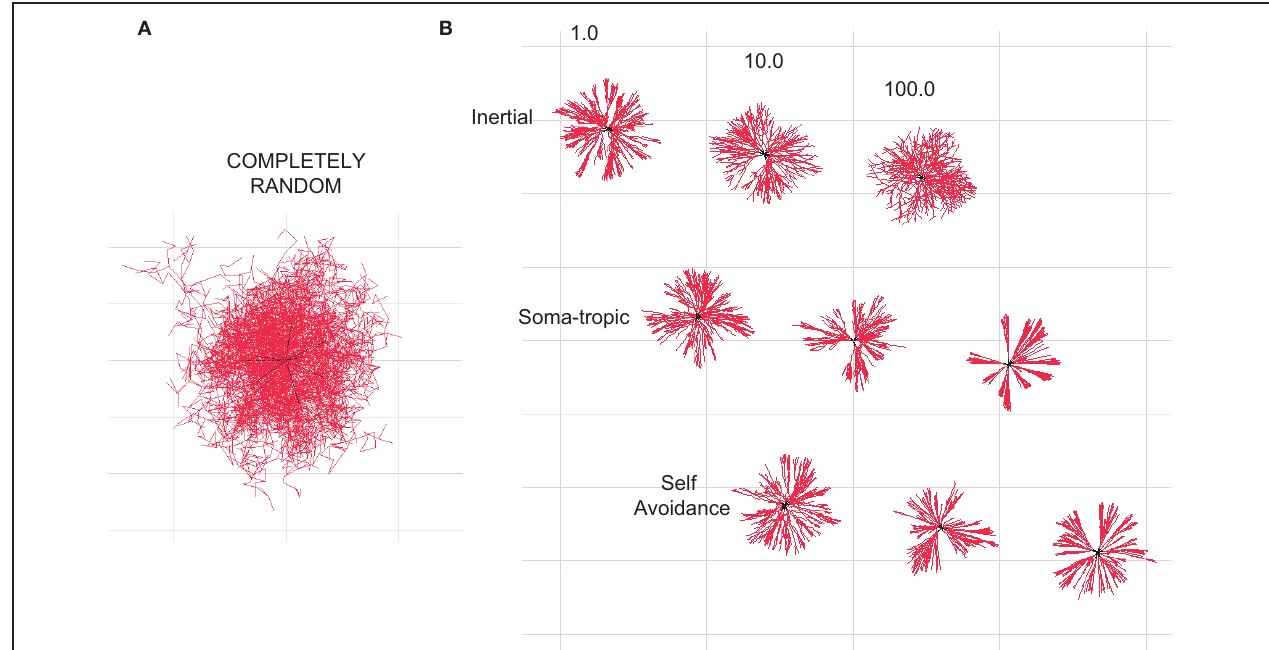
emerge when different homotypic growth biases are added to define the geometry. The influence of different levels of inertial, soma-tropic, and self-avoidance are shown. Structures are bounded by a cube with side dimensions of 50 μ